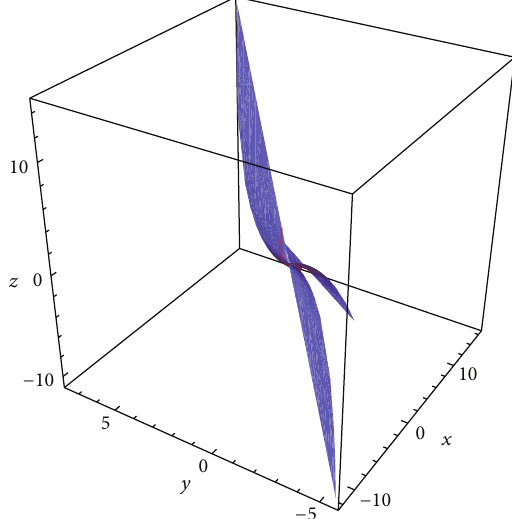
Figure 4: The cylindrical ruled surface 𝜑 with pseudo null curve.